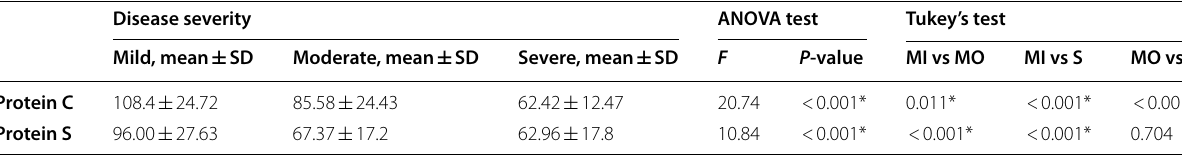
* Statistically significant